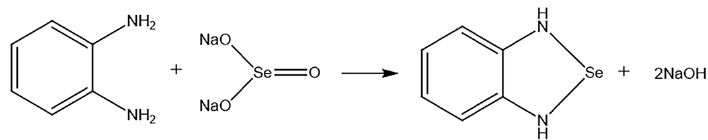
Figure 8. The reaction between O-phenylenediamine and Sodium Selenite.